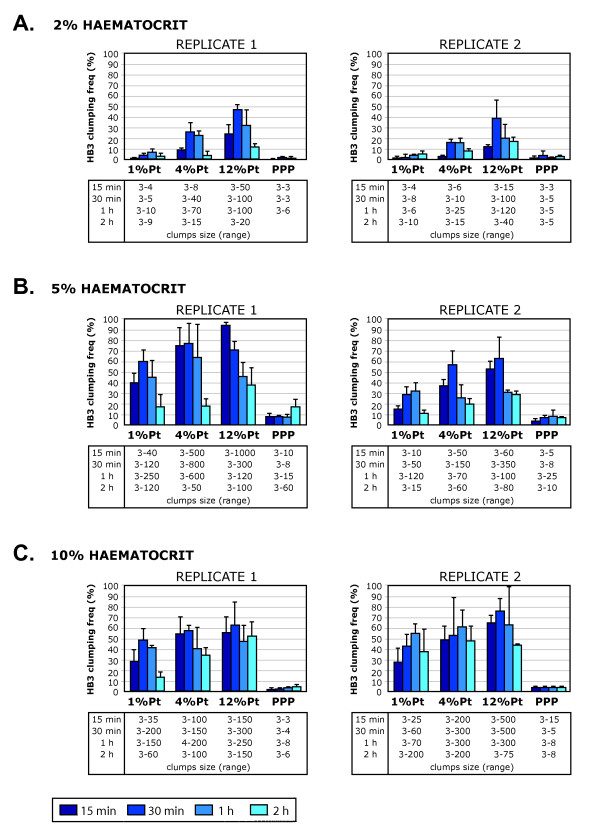
Comparison of HB3 platelet-mediated clumping frequencies detected by in vitro assays performed at a constant haematocrit (Ht) but varying parasitaemia (Pt). A. In vitro platelet-mediated clumping assays were set up at 2% Ht and varying Pt (1%, 4% and 12%) and the clumping frequency (percentage of IE in clumps out of at least 500 IE counted) was assessed by fluorescence microscopy of wet preparations at four time points (15 min, 30 min, 1 h and 2 h). The mean and standard deviation of three wet preparations from each time point are shown, and the range of clump sizes (number of IE forming the clumps) detected in each assay and each time point is indicated. Two replicates of each experiment, done on different days and with platelet-rich plasma from different donors, are shown. Each experiment included a negative control performed with PPP (platelet-poor plasma) and 12% Pt to determine the potential for non-platelet mediated clumping. B. As above but at 5% Ht. C. As above but at 10% Ht.